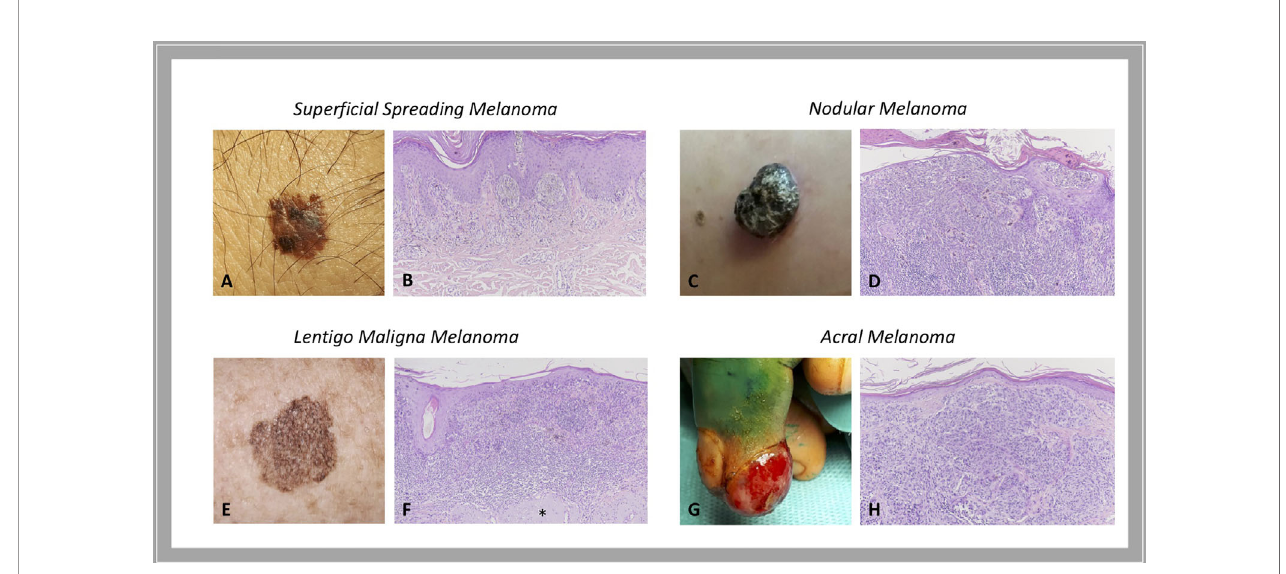
FIGURE 1 | Histological subtypes of melanoma: clinical-pathological correlations. Super fi cial spreading melanoma is a pigmented macule with irregular contours (A) that, when invasion occurs, presents as a proliferation of atypical melanocytes in the papillary dermis (B) . Nodular melanoma is a brown-to-black exophytic tumor (C) characterized by a predominant vertical growth phase, with pigmented epithelioid or spindle atypical melanocytes that invade the reticular dermis (D) . Lentigo maligna melanoma presents as a large, pigmented macule with irregular contours on sun damaged skin (E) that is described histologically as a lentiginous proliferation of atypical spindle melanocytes at the dermo-epidermal junction with invasion into the papillary dermis; actinic damage and dermal elastosis (*) are typically present in the surrounding skin (F) . Acral melanoma may be an amelanotic nodule localized on the extremities (G) characterized by a proliferation of atypical, not pigmented, spindle melanocytes throughout the dermis (H) . Courtesy of Dermatology Unit, Department of Clinical and Experimental Medicine, University of